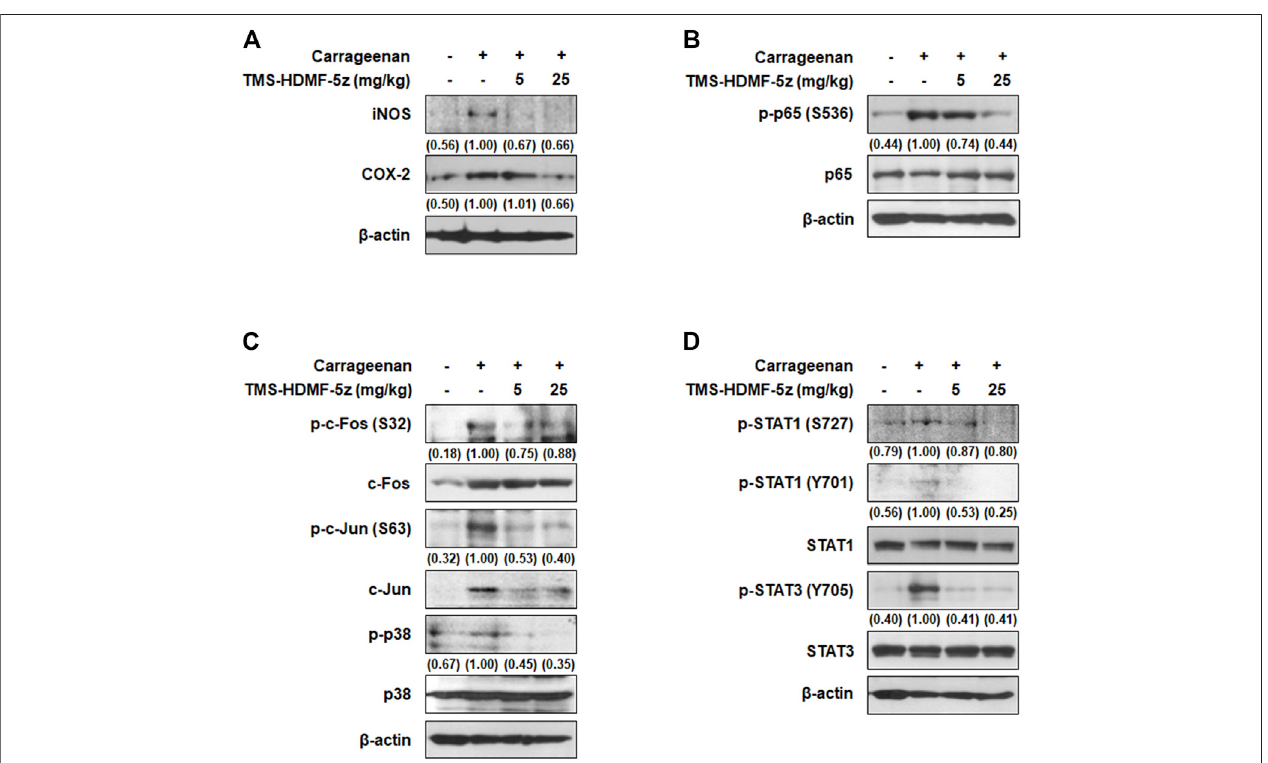
FIGURE 7 | Inhibitory effects of TMS-HDMF-5z on the expression of iNOS, COX-2, and in fl ammatory transcription factors in carrageenan-induced paw tissues. (A-D) Paw tissues were homogenized after 5 h of TMS-HDMF-5z treatment, and whole proteins were prepared for western blotting to detect the protein expression of iNOS, COX-2, p-p65 (S536), p65, p-c-Fos (S32), c-Fos, p-c-Jun (S63), c-Jun, p-p38 MAPK, p38 MAPK,p-STAT1(S727, Y701), STAT1, p-STAT3 (Y705), and STAT3. The relative optical density ratio vs. total form was determined using a densitometric analysis program (Bio-Rad Quantity One Software, version 4.6.3 (Basic), Bio- Rad Laboratories Inc., CA, United States), normalized to the internal